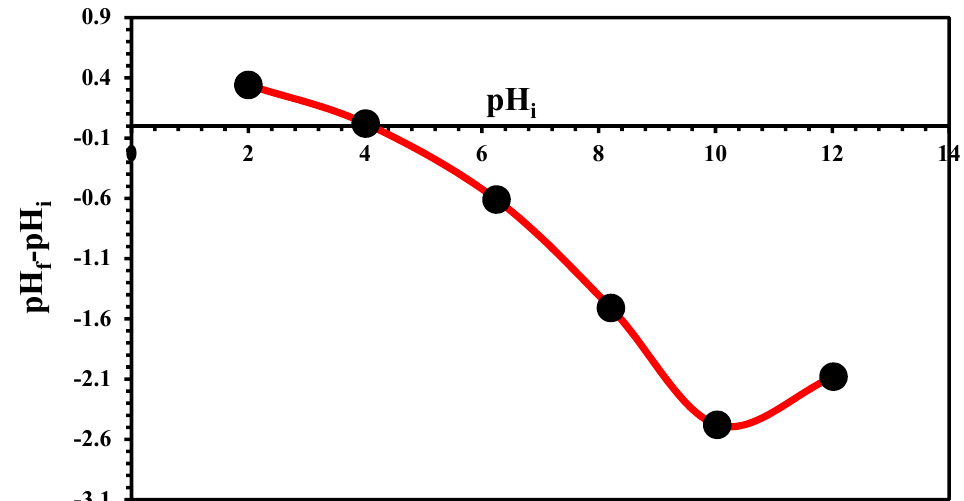
Figure 12. Determination of the point of zero charge of BiP-500 photocatalyst: pH pzc = 4.01.